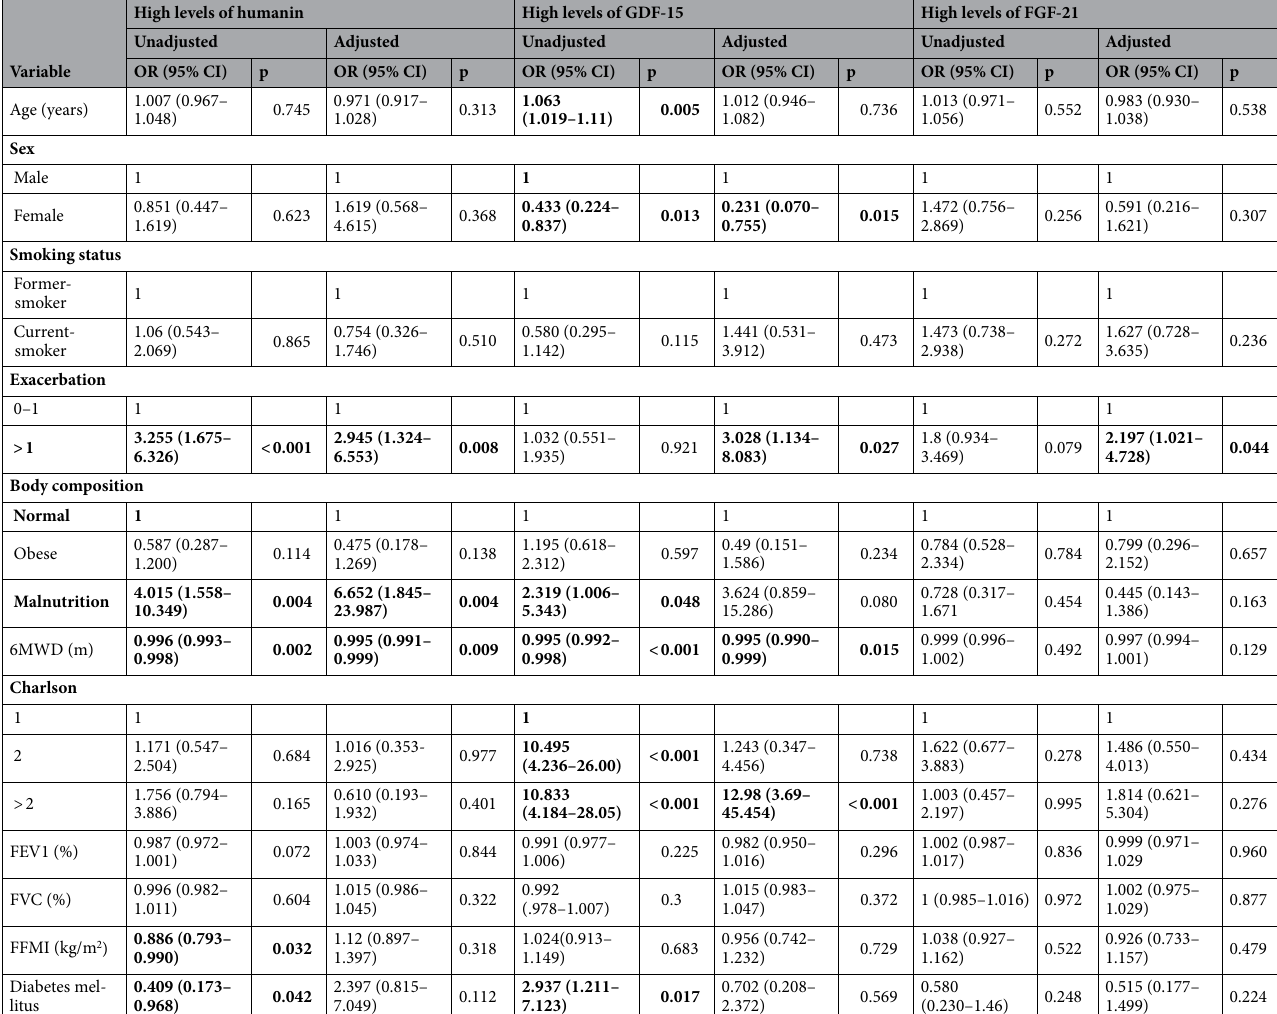
Table 2. Associations between chronic obstructive pulmonary disease characteristics and levels of humanin, GDF-15 and FGF-21 (dependent variables) using uni and multivariate logistic regression. High levels of humanin = humanin higher than median (> 246 pg/mL). High levels of GDF-15 = GDF-15 higher than the median (> 1244 pg/mL). High levels of FGF-21 = FGF-21 higher than the median (> 321.9 pg/mL). Exacerbations = Need for antibiotic or systemic corticosteroids, Malnutrition = BMI < 18.5 kg/m 2 or between 18.5 and 22 kg/m 2 , combined with low FFMI (< 17 kg/m 2 for men and < 15 kg/m 2 for females, high risk of exacerbation = 2 or more exacerbations during previous year or 1 previous admission. 6MWD 6 Minute Walk Test Distance, FEV1 forced expiratory volume in the first second, FVC forced vital capacity, FFMI Fat Free Mass Index, Bold font indicates statistical